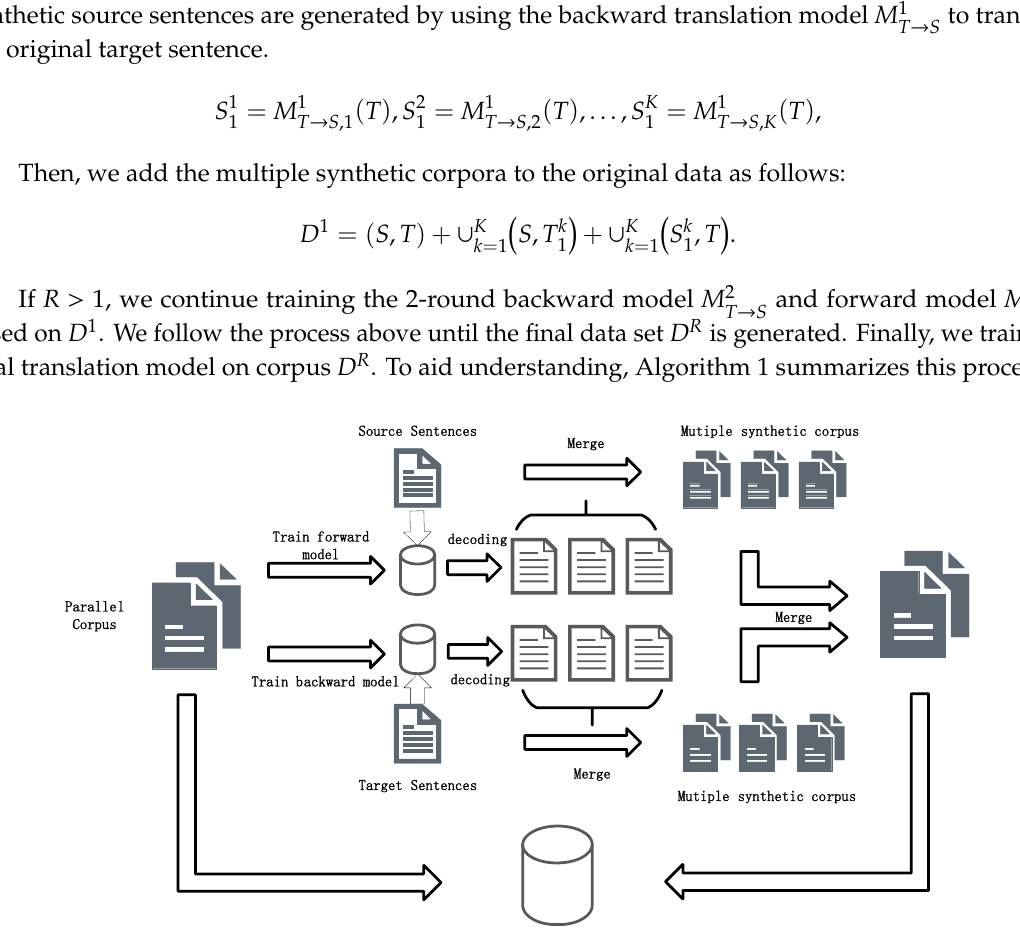
Algorithm 1. Our data augmentation strategy.